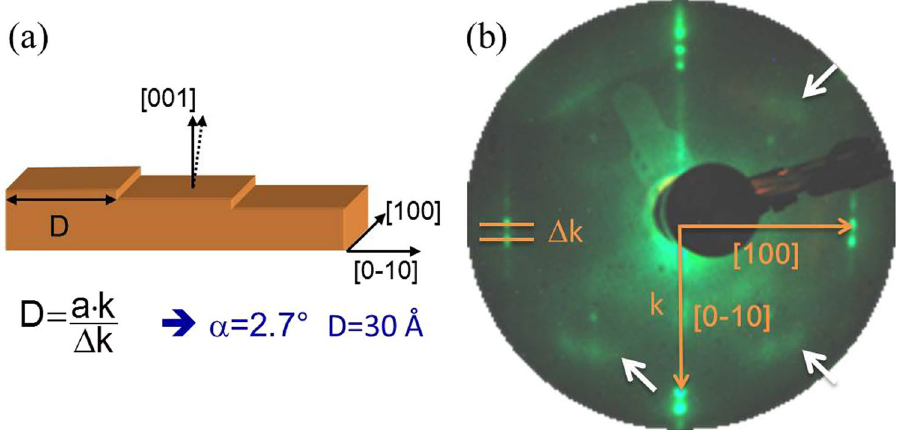
Figure 1. ( a ) Schematic representation of the Fe(0 18 1) surface with a miscut angle of 3° and steps running along the [0 ± 1 0] direction. ( b ) Typical LEED picture of the C:c(3 √ 2 × √ 2):Fe(0 18 1) surface measured at 50 eV. At this electron energy the surface sensitivity is the highest. Two distinct features are observed: i) intense spots from the (0 0 1) surface split by presence of the steps along the [0 ± 1 0] directions, ii) weak spots at c(2 × 2) positions surrounded by faint halos at the positions of the c(3 √ 2 × √ 2) reconstruction, indicated by white arrows. From the splitting of the (0 0 1) spots an average terrace size of D = 30 Å has been